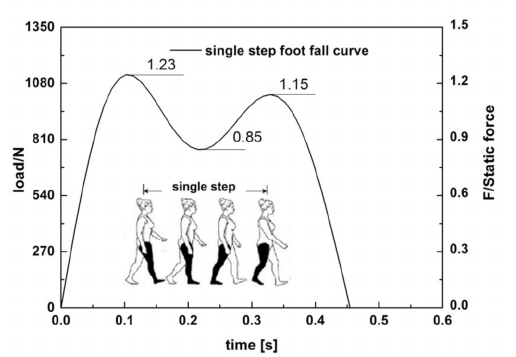
Figure 17. Single footstep